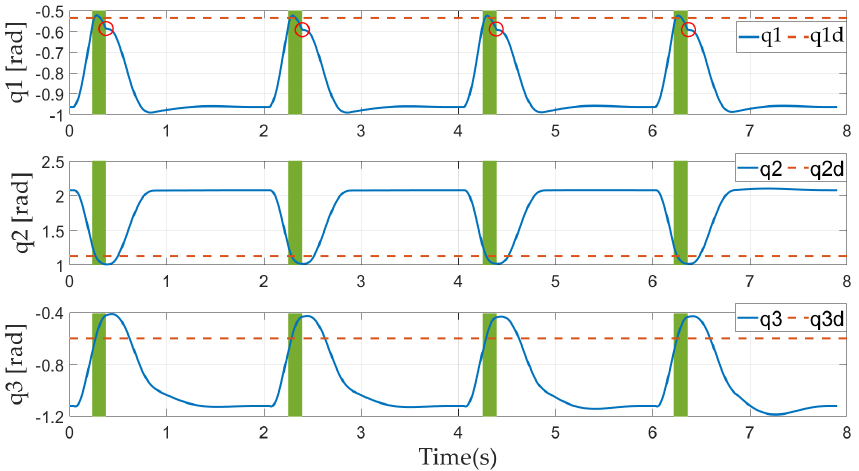
Figure 12. Joint trajectories in simulation.